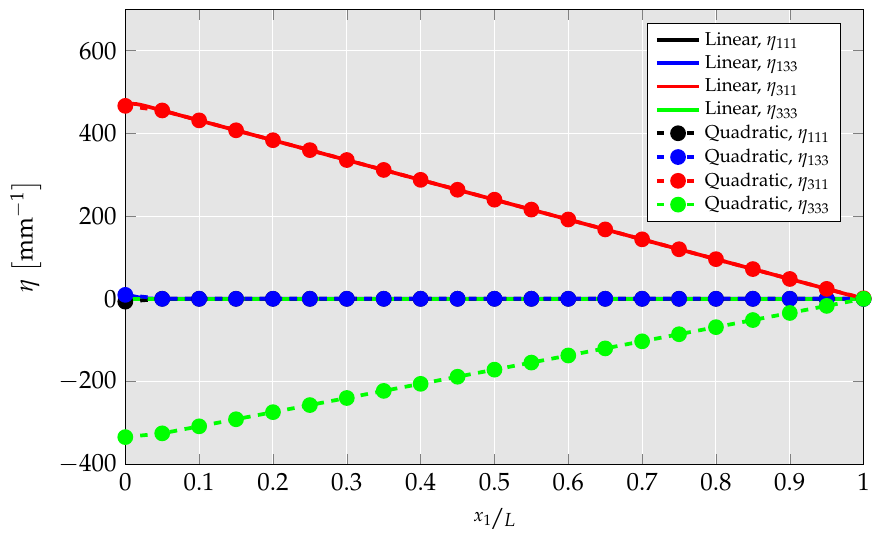
Figure 17. Comparison of mechanical strain gradient components calculated by using linear and quadratic element along the length of the beam for prescribed mechanical displacement.